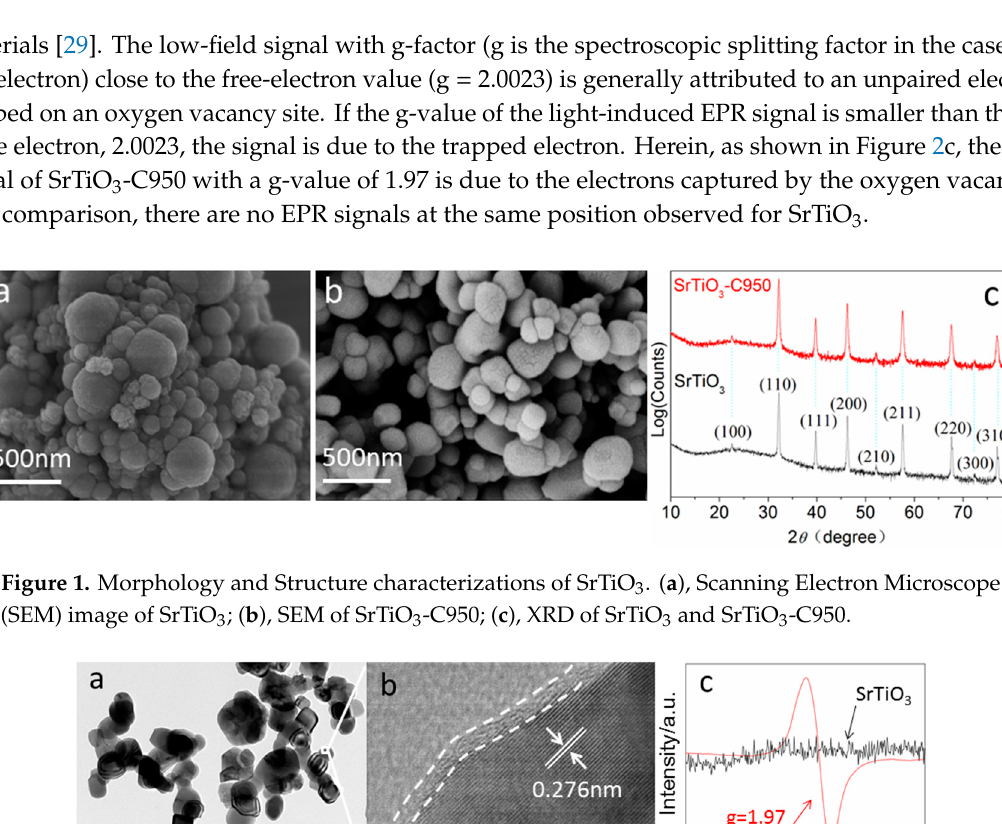
Figure 1. Morphology and Structure characterizations of SrTiO 3 . ( a ), Scanning Electron Microscope (SEM) image of SrTiO 3 ; ( b ), SEM of SrTiO 3 -C950; ( c ), XRD of SrTiO 3 and SrTiO 3 -C950.